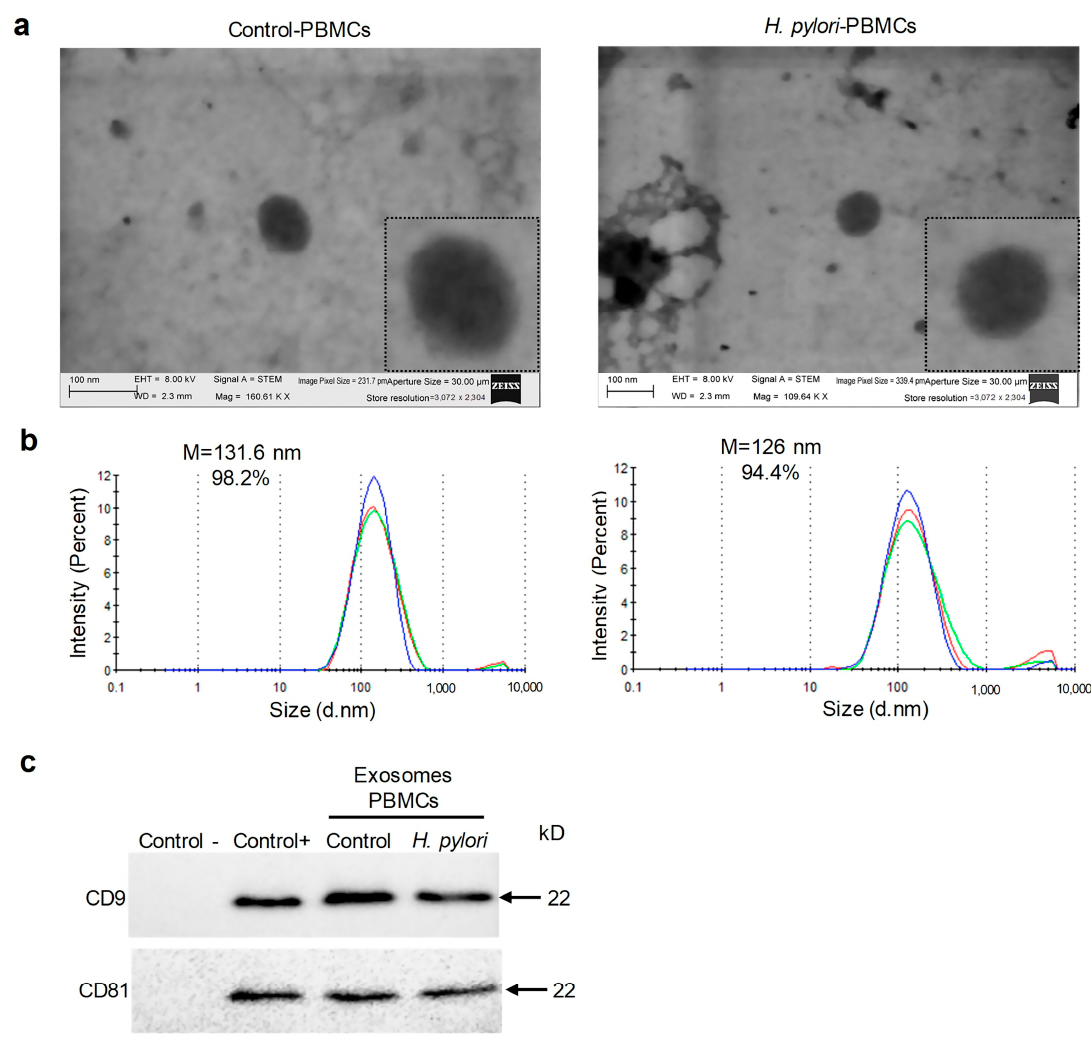
Figure 2. H. pylori -infected and -uninfected PBMCs secrete exosomes. Exosomes were isolated by ultracentrifugation. ( a ) Representative photomicrographs of exosomes that were secreted by Control-PBMCs and H. pylori -PBMCs at a MOI 1:100, observed in a TEM. The scale bars represent 100 nm. ( b ) Exosome particle size that was determined using the Zetasizer instrument. In the graphs, the x axis represents the particle size in nm and the y axis the percentage of particles. Each curve represents the size and percentage of exosomes. ( c ) Tetraspanins CD9 and CD81 were detected by Western blot in 30 µg of total proteins from exosomes that were secreted by Control-PBMCs and H. pylori -PBMCs. As a negative control, 30 µg of BSA were used and as a positive control 30 µg of proteins from exosomes that were isolated from the breast cancer cell line MDA-MB-231 were used, which secrete abundant exosomes. All experiments were performed in triplicate.